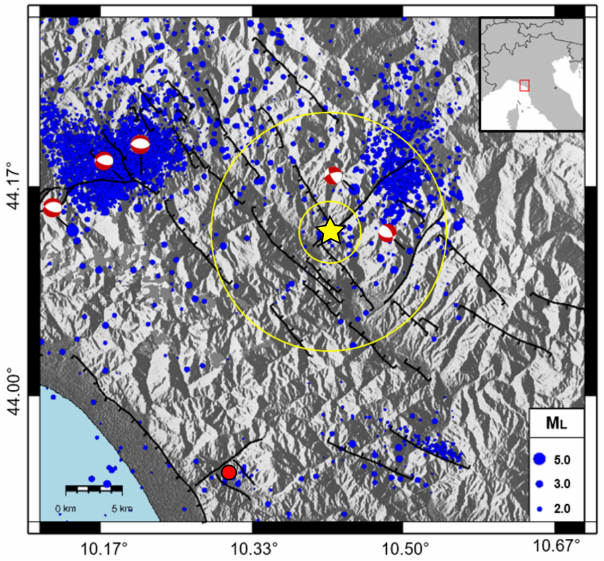
Figure 1. Study area: the Prà di Lama sinkhole is marked by the yellow star. Black tick lines are faults. Blue dots are the earthquakes between 1986 and 2017. Focal mechanisms are from the Regional Centroid Moment Tensor (RCMT) catalogue. The yellow circles represent the areas with radii of 3 and 10km used for the seismicity analysis. The red dot is the Camaiore sinkhole (Buchignani et al., 2008; Caramanna et al., 2008). The red box in the inset marks the location of the area shown in the main